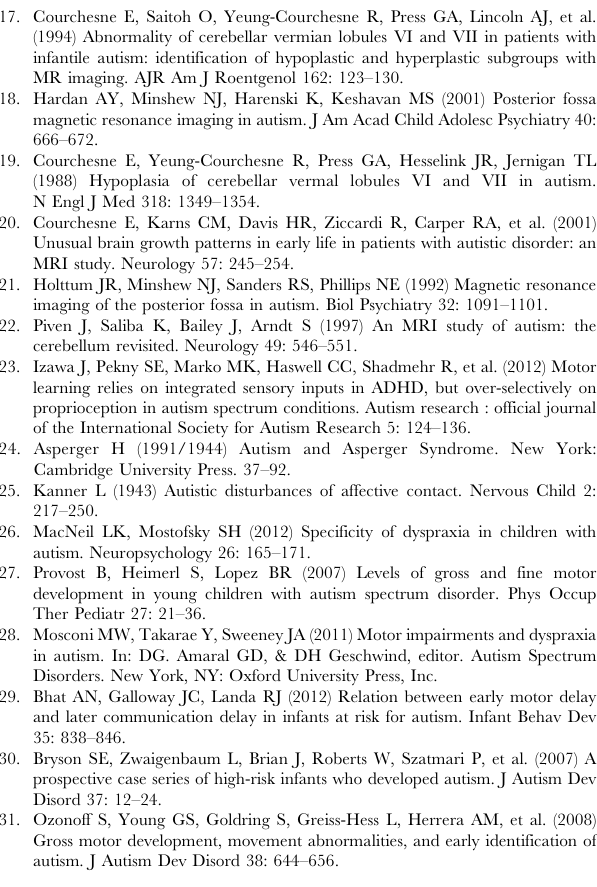
Table S1 Relationships between adaptation perfor- mance and clinical/demographic characteristics for subjects with Autism Spectrum Disorder (ASD).